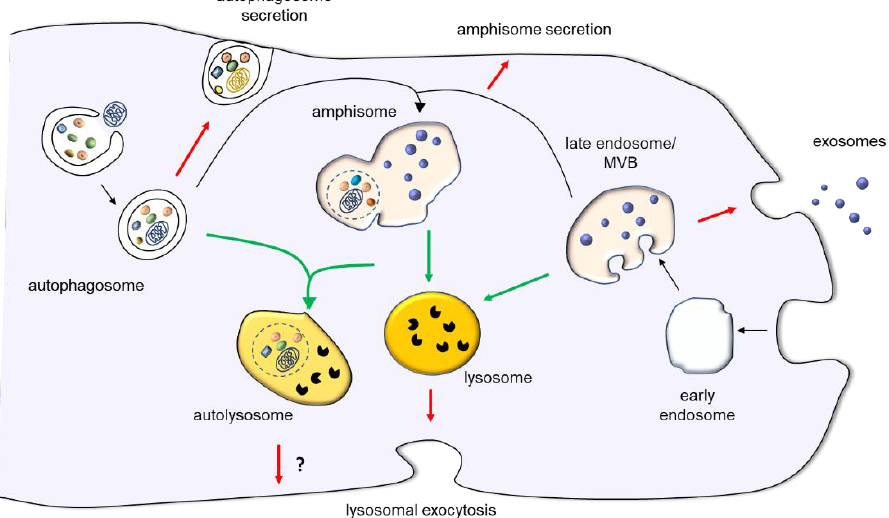
Figure 1. Overview of lysosomal exocytosis, exosome release and autophagy-dependent secretory pathways. Lysosomal exocytosis leads to the secretion of lysosomal content upon lysosome fusion with plasma membrane. Exosomes originate from the inward budding of late endosome membrane, which originates MVBs. They are either released extracellularly upon exocytosis or degraded into lysosomes. Autophagy is a cellular process leading to sequestration of cytosolic cargoes for their degradation within lysosomes. However, the autophagic machinery is also involved in autophagy-dependent secretion of autophagosomes. In addition to merging with lysosomes or plasma membrane, autophagosomes can also fuse with late endosomes/MVBs to produce amphisomes. In turn, amphisomes can either fuse with lysosomes to degrade their content or with plasma membrane. The red arrows indicate fusion with plasma membrane, the green arrows, fusion with lysosome, and the black arrows, pathways leading to organelle maturation and to the intersection between autophagic and endocytic pathway.